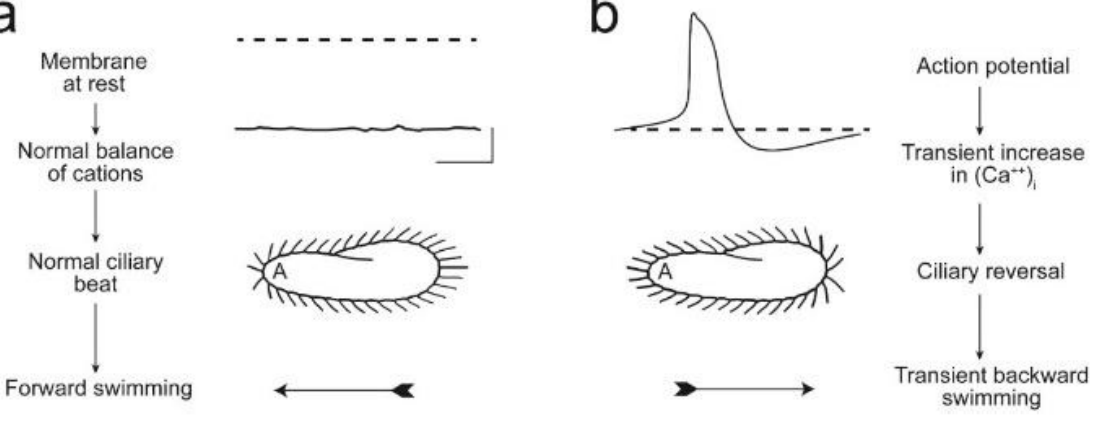
Figure 2. ( a ) These images illustrate that the resting membrane potential of Paramecium is negative (about − 25 to − 40 mV); the corresponding ciliary beat is toward the posterior of the cell and the cell swims forward. ( b ) In depolarizing solutions, such as high K + or Ba 2+ , the cell’s plasma membrane depolarizes and reaches threshold for the action potential. During the action potential, Ca 2+ enters the cilia through voltage-gated channels; the high levels of Ca 2+ change the power stroke of the cilia, which now beat most strongly toward the anterior and move the cell backward. The action potential is quickly terminated and the Ca 2+ removed from or sequestered in the cilia, allowing ciliary beat and swimming to return to normal. From [94] Figure 1; used with permission.